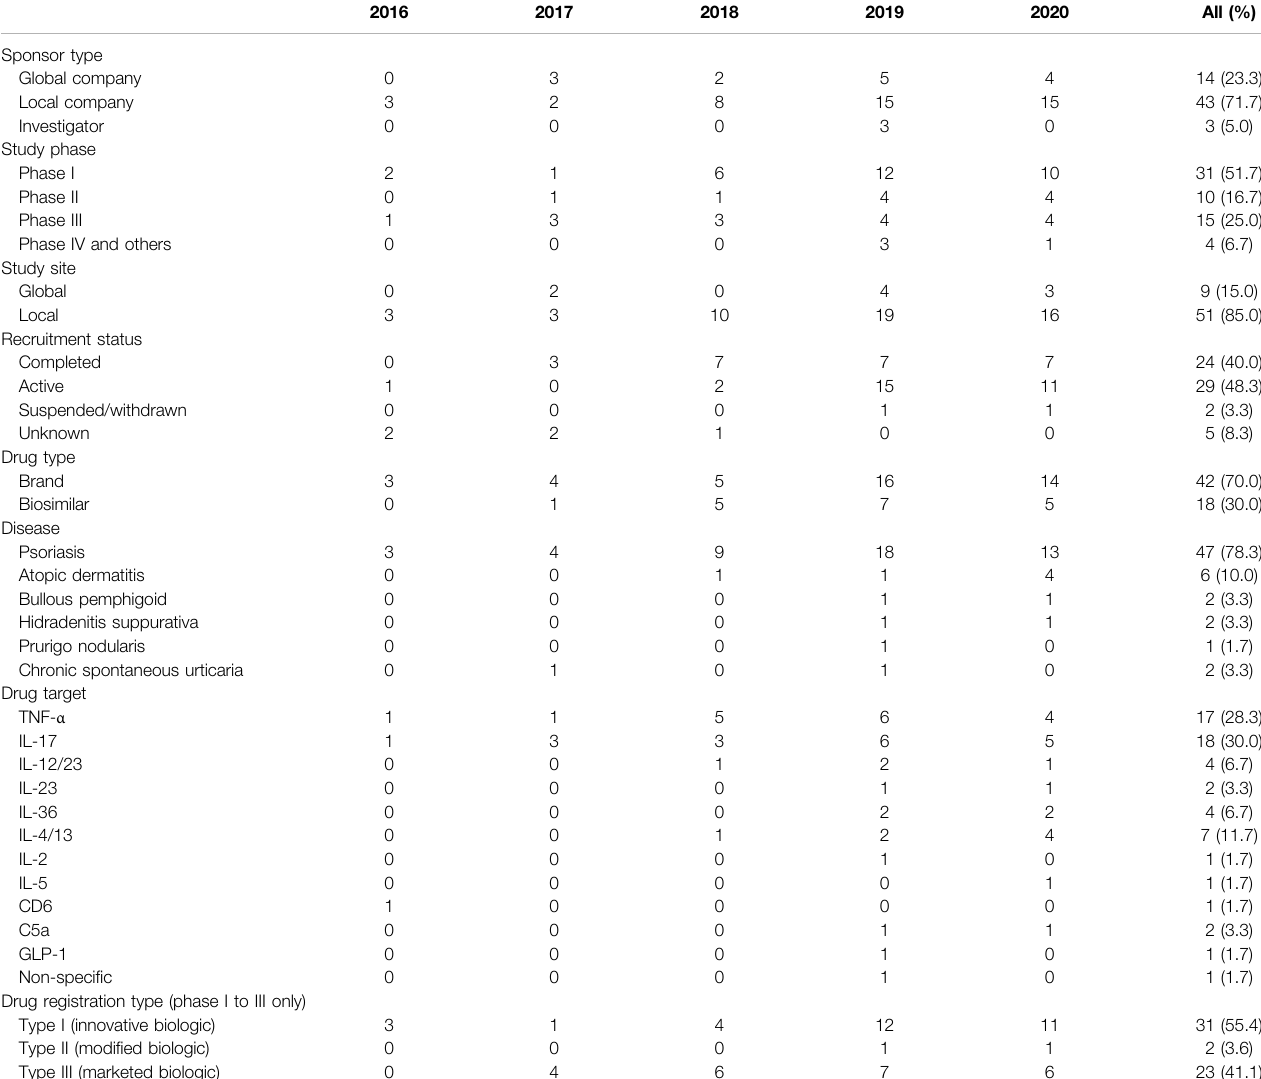
TABLE 1 | Characteristics of dermatological biologic trials by year (2016 –